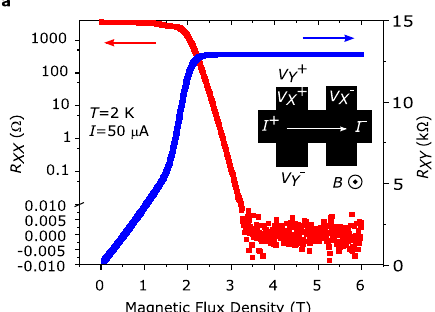
in thebottomtwo rows.There are two subarrays, each consisting of 118 individual Hallbars, resulting in 236 elementsforthe entire array.